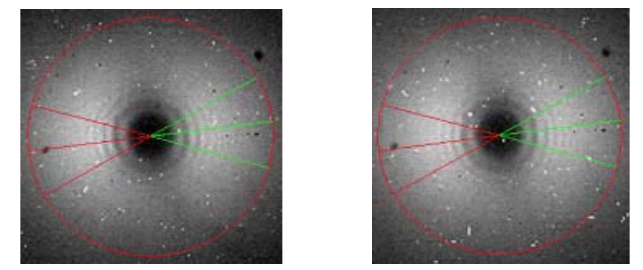
FIG. 17. (Color) ODTRI (left) and OTRI (right) for the second beam tune of the ATF linac.